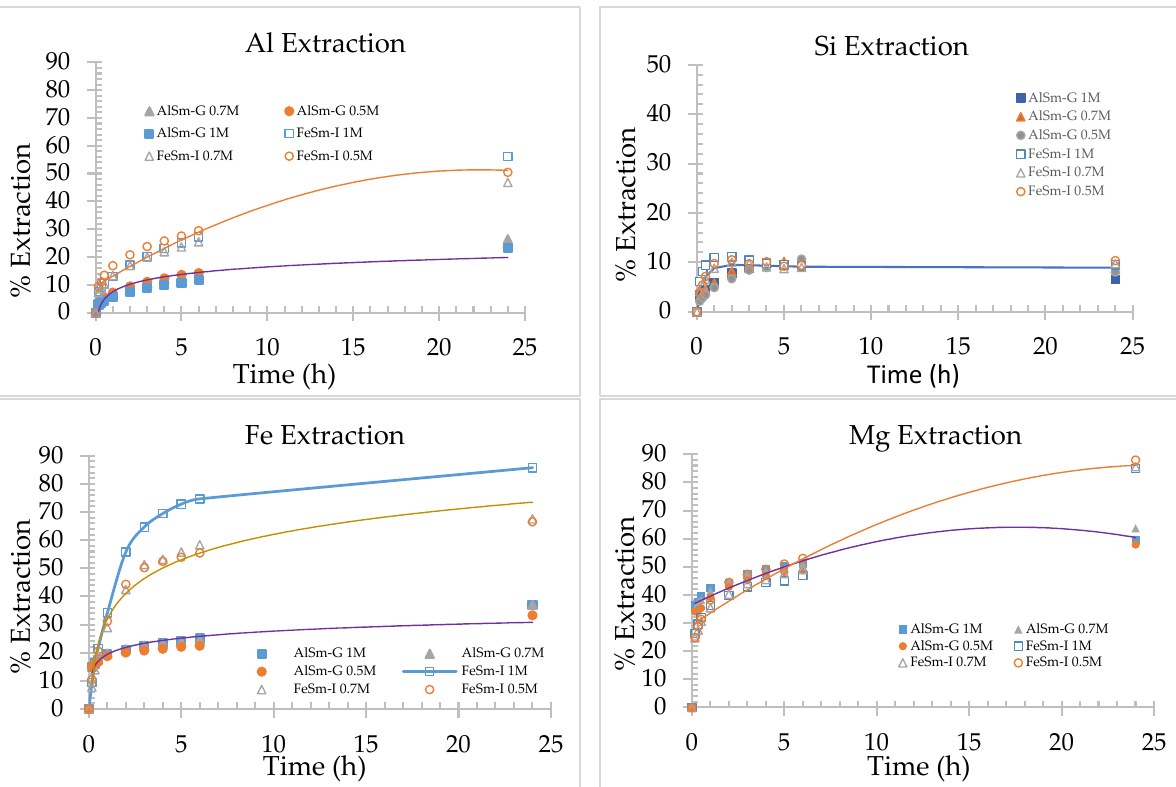
Figure 3. Extraction of metals versus time for AlSm-G and FeSm-I smectites in oxalic acid (80 °C; acid concentrations of 0.5 M, 0.7 M, and 1 M; 2% of pulp density).